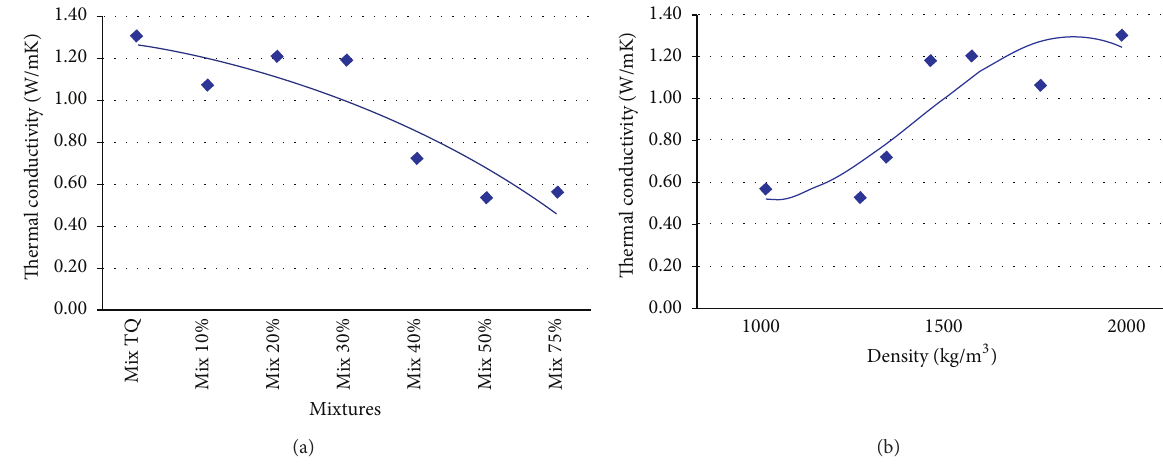
Figure 14: (a) Thermal conductivity for rubber cement composites on day 60; (b) thermal conductivity against